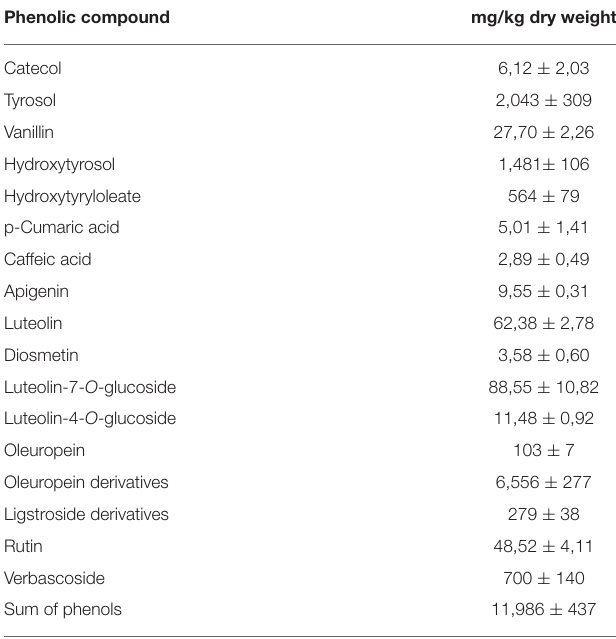
TABLE 1 | Phenols, expressed as mg/kg in dried olive mill wastewater (DOMWW) obtained by liquid chromatography–tandem mass